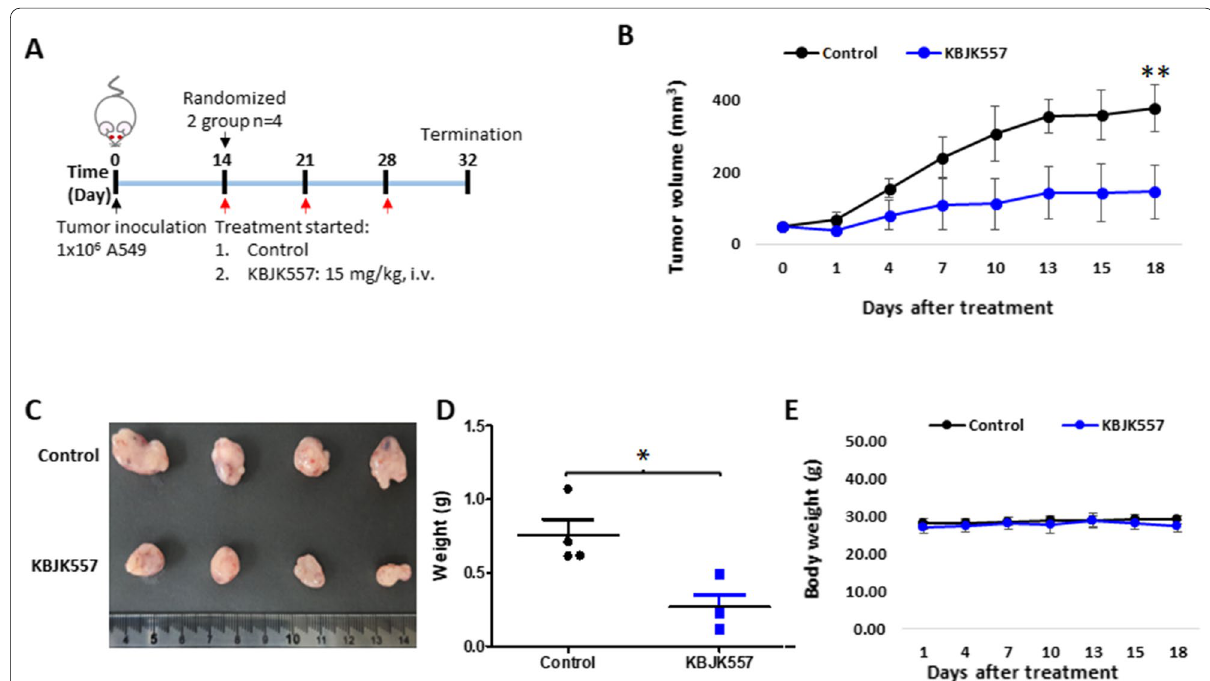
Fig. 4 In vivo anticancer effect of KBJK557 in tumor xenograft mice models. KBJK557 treatment (15 mg/kg body weight/100 μL per 1 week) of A549 tumor‑bearing mice. A Treatment schedule for the A549 cells xenograft tumors model treated with vehicle solution and KBJK557. B The change of tumor volume was measured every 3–4 days. ( n 4) ** P < 0.01. C Tumors picture for size. D Tumor weight of all mice in each group. * P < 0.05. E The = change of body weight of all mice was measured every 3–4